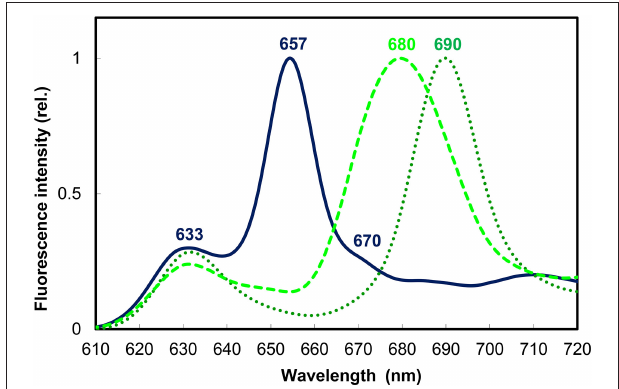
FIGURE 3 | Normalized 77K fluorescence emission spectra of 10-day-old dark-grown wheat ( Triticum aestivum ) leaves before (solid line) and after illumination with white light of 100 µ mol s − 1 m − 2 photon flux density for 10s (dotted line) and a subsequent 15min dark incubation to reach the end stage of Shibata shift (broken line). Experimental conditions were as in Solymosi et al. (2002) and Smeller et al. (2003).